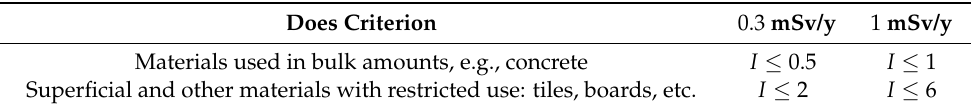
Table 1. Limit values for the index ( I ) [8]. Does Criterion 0.3 mSv/y 1 mSv/y Materials used in bulk amounts, e.g., concrete I ≤ 0.5 I ≤ 1 Superficial and other materials with restricted use: tiles, boards, etc. I ≤ 2 I ≤